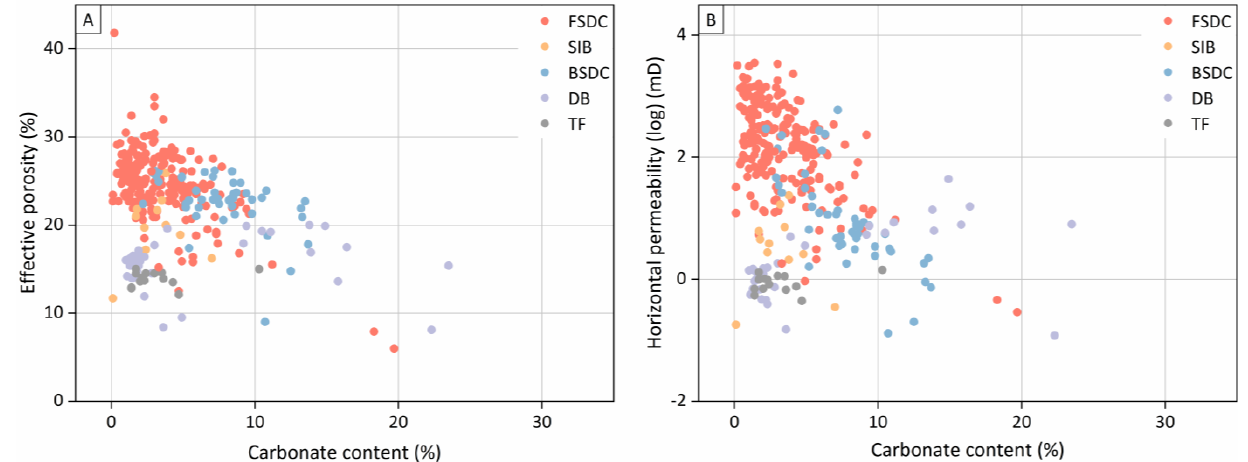
Figure 11. Plots of reservoir properties versus carbonate content derived from routine core analysis, split by different sedimentary microfacies. ( A ) Core effective porosity versus carbonate content; ( B ) Core horizontal permeability versus carbonate content. (FSDC — submerged distributary channel (fan delta), SIB — submerged interdistributary bay, BSDC — submerged distributary channels (braided delta), DB — distal bar, TF — turbidite fan).